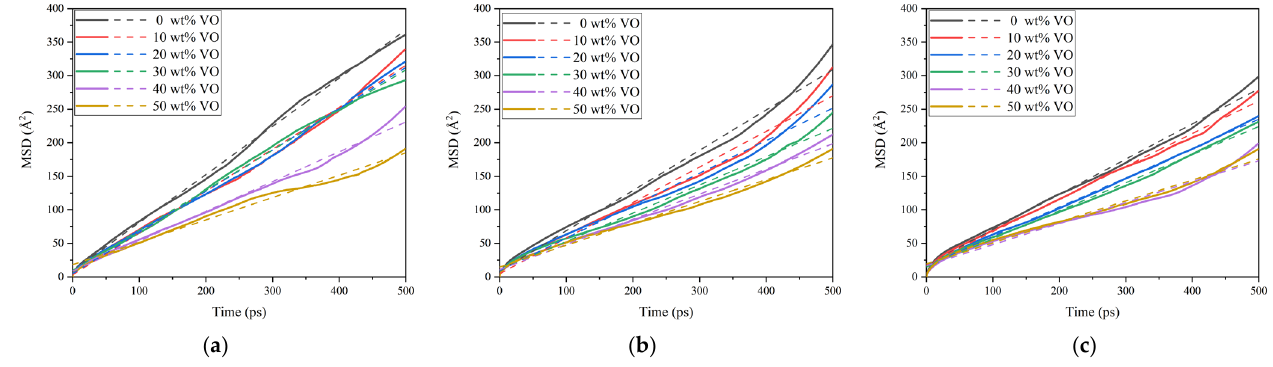
Figure 4. MSD curves of water molecules in each mixed oil model with different water contents: ( a ) 1 wt%; ( b ) 2 wt%; ( c ) 3 wt %.